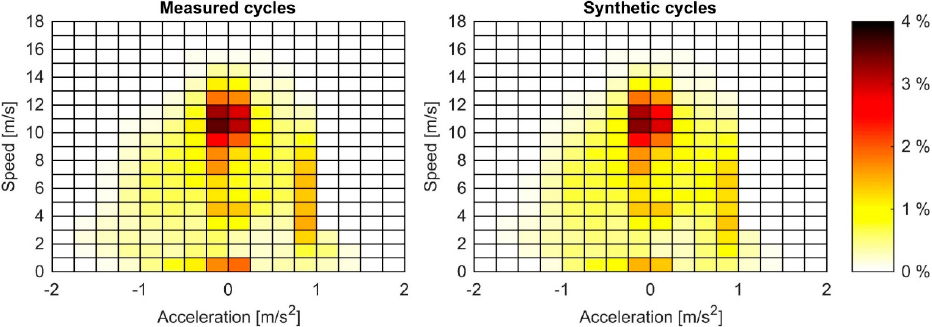
Figure 6. Speed-acceleration distributions of the measured and 3000 synthetic cycles.